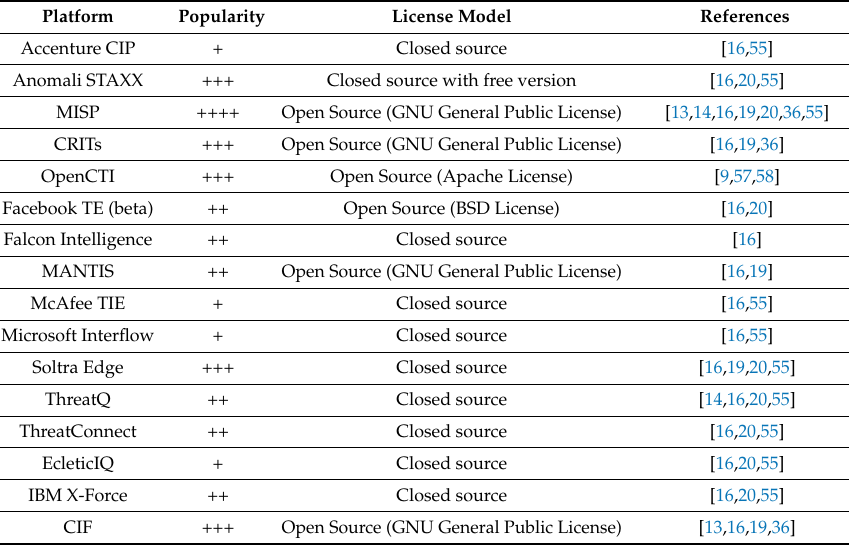
Table 6. TI platforms described by popularity and license